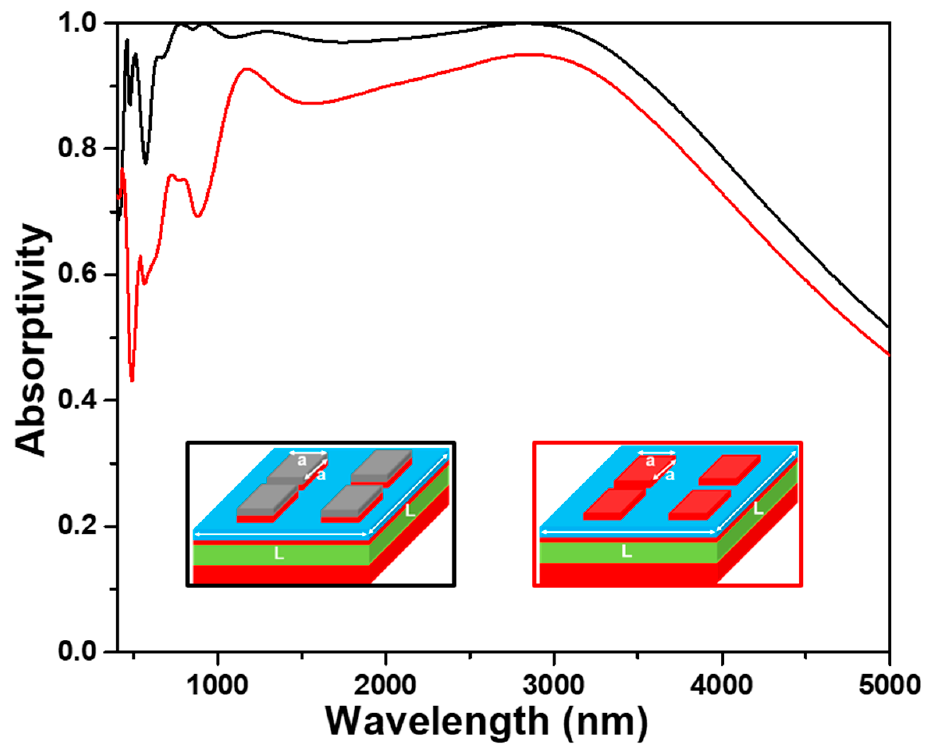
Figure 4. Effect of the TiO 2 anti-reflection layer on the absorption properties of the designed absorber. Black line and red line were used for with and without anti-reflection layer.